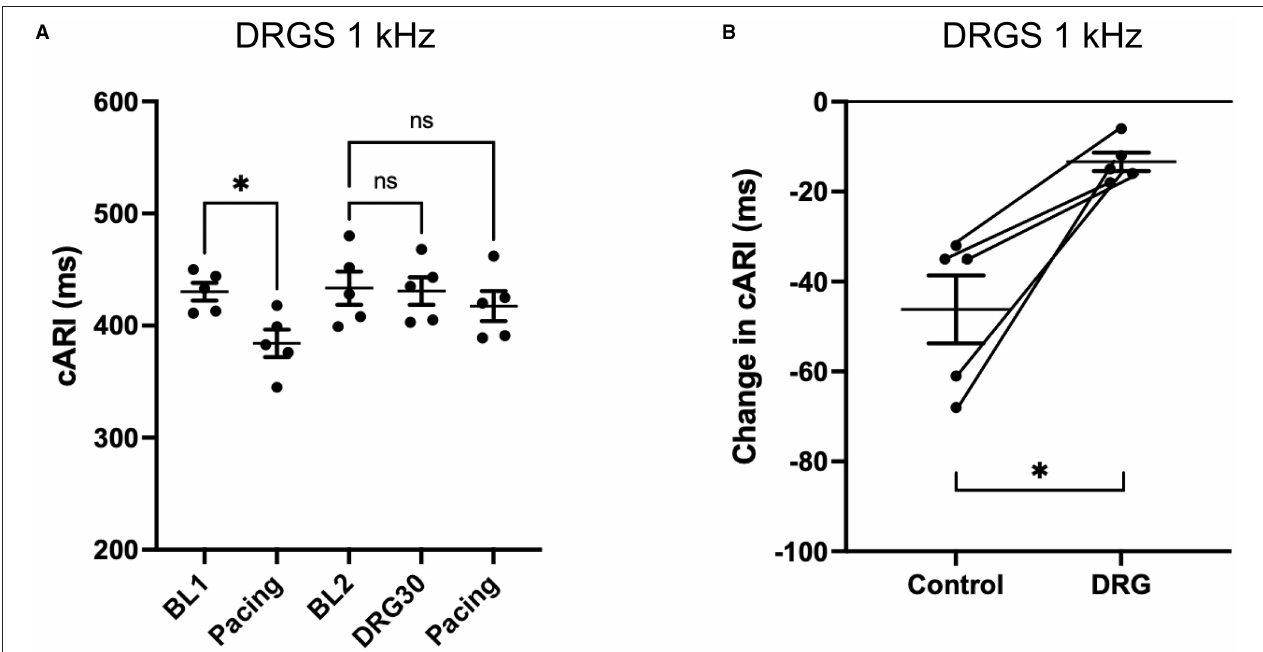
FIGURE 4 | Change in activation recovery interval (ARI) during the experiments with DRG stimulation at 1kHz. (A) Changes in ARI corrected by heart rate (cARI) during the experimental protocol. Before DRG stimulation, cARI reduced after the pacing with significant difference (* P = 0.0378 from BL1), but there was no significant difference after DRG stimulation ( P = 0.2858 from BL2). BL, baseline; S1S2 Pacing, 1min post-pacing before or after DRG stimulation; DRG30, 30min after the initiation of DRG stimulation. (B) Reduction of cARI at 1min post-pacing from baseline or DRG30. DRG stimulation decreased the reduction of cARI with significant difference (* P = 0.013). Data are reported as mean ± standard error (SE).